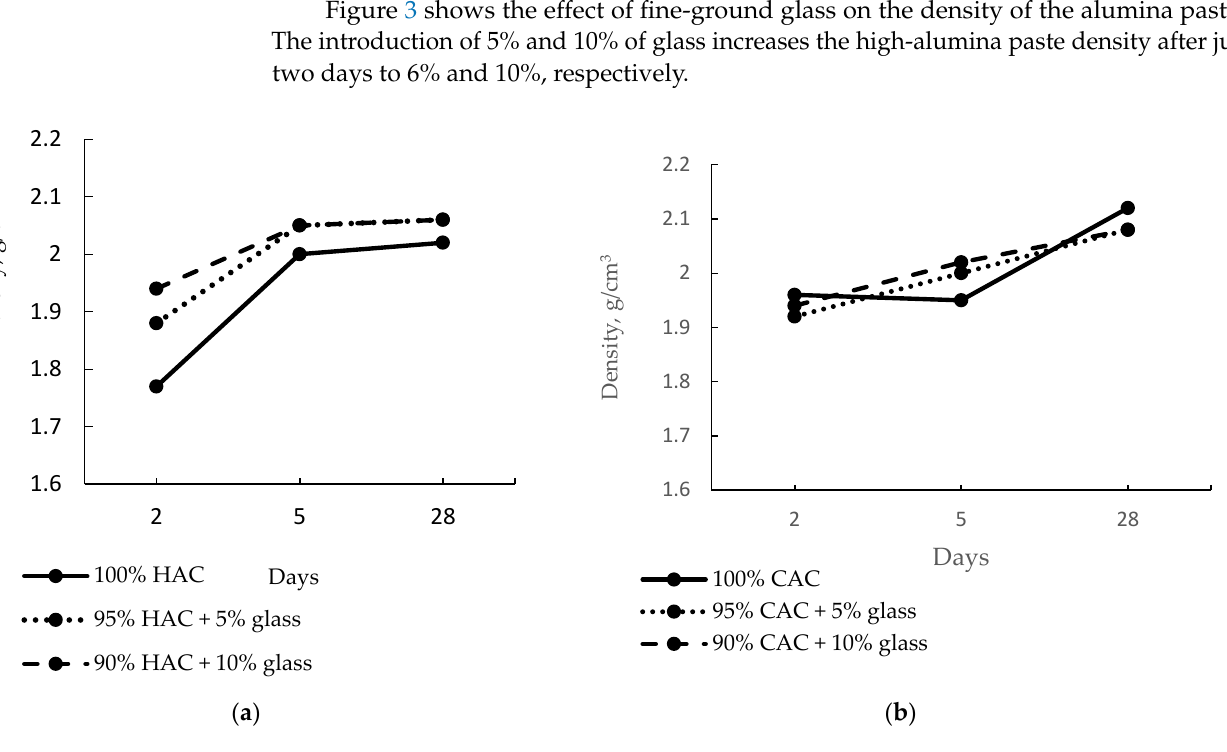
Table 4. Density of the main hydration products of aluminous cement [1,2,64]. Phases